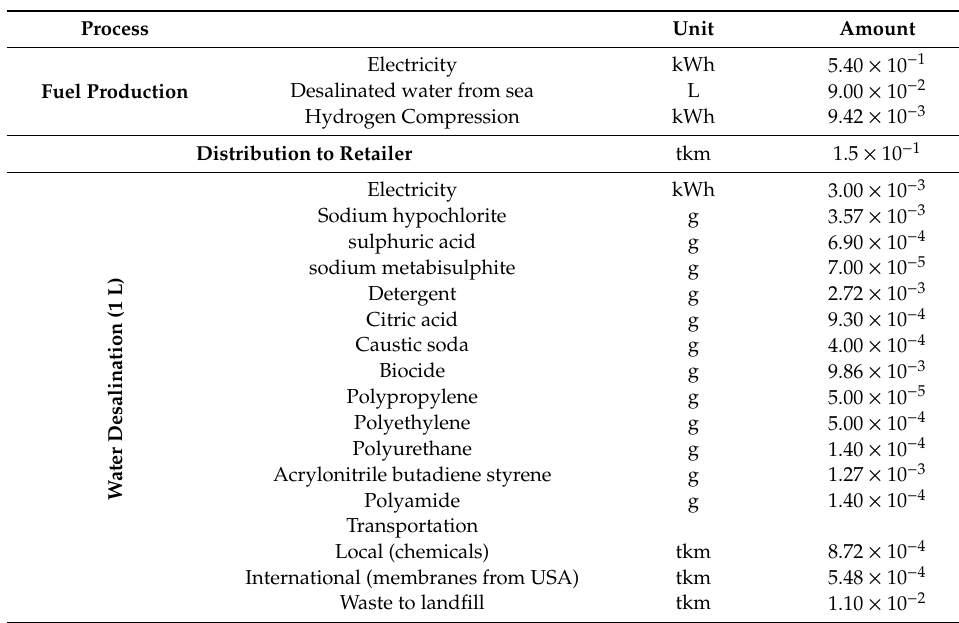
Table 8. Summary of inventory for hydrogen production (FU = per VKT; water desalination inventory for 1 L).